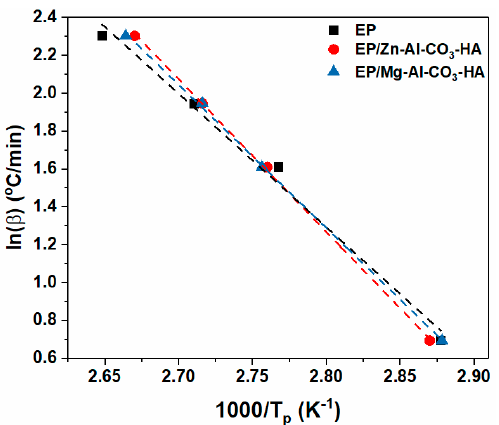
Figure A3. Plots of ln( β ) vs. 1/ T for neat epoxy and its prepared nanocomposites based on the FWO model.